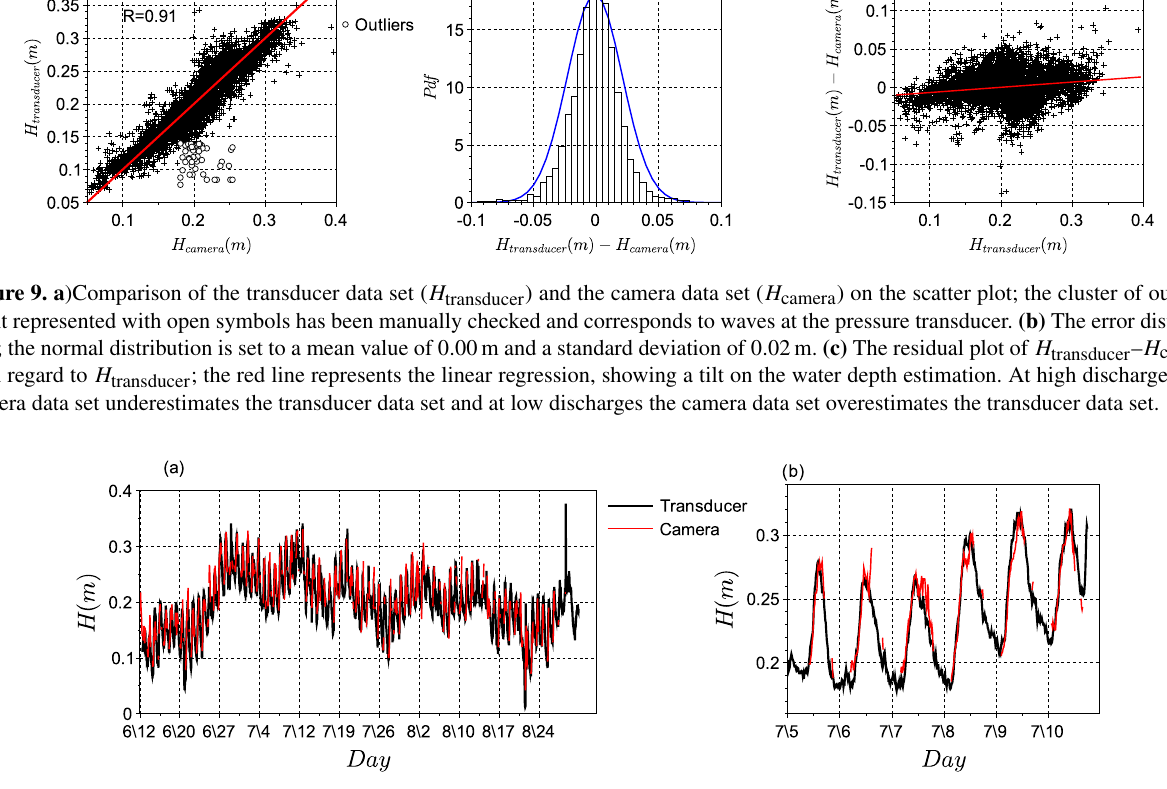
Figure 10. Summer 2015 stage time series. The black line represents the transducer data set ( H transducer ) and the red line is the camera data set ( H camera ). The estimated error on the camera stage relative to pressure transducer is around 3cm. Panel (a) shows data from mid-June to the end of July 2015. The camera data set fits the transducer data set. The daily trend as well as the general monthly trend are reproduced (b) from 5 to 10 July 2015. At hourly resolution, the trend of the camera stage follows the transducer data closely. However, on the rising stage, the camera data set underestimates the transducer water stage, and on the falling stage, the picture data set slightly overestimates the transducer